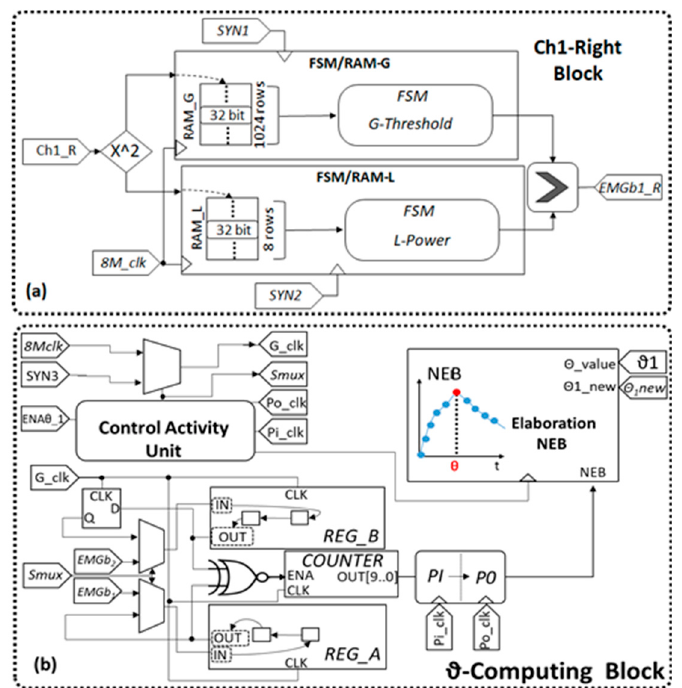
Figure 5. Functional block expansions: ( a ) Ch1-Right Block – ( b ) ϑ -Computing Block.